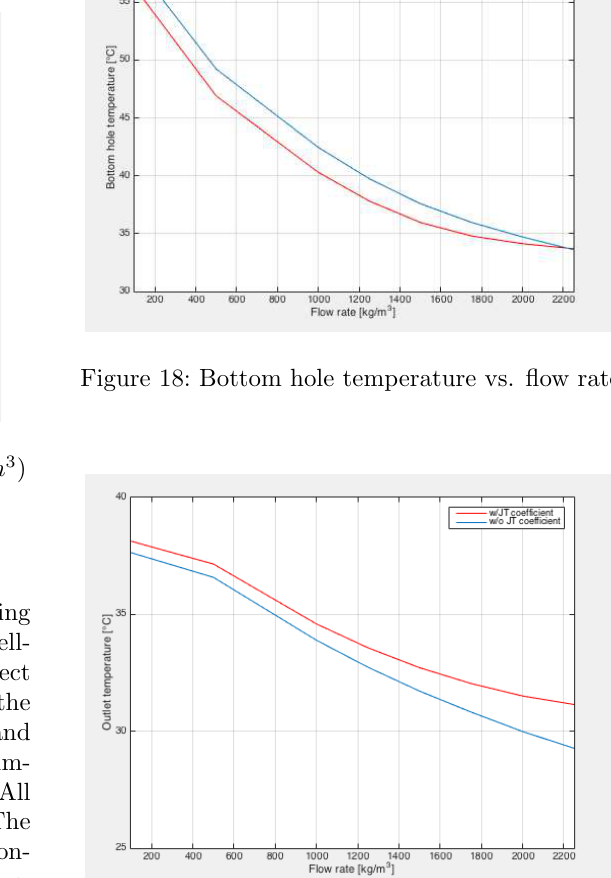
Figure 19: Outlet temperature vs. flow